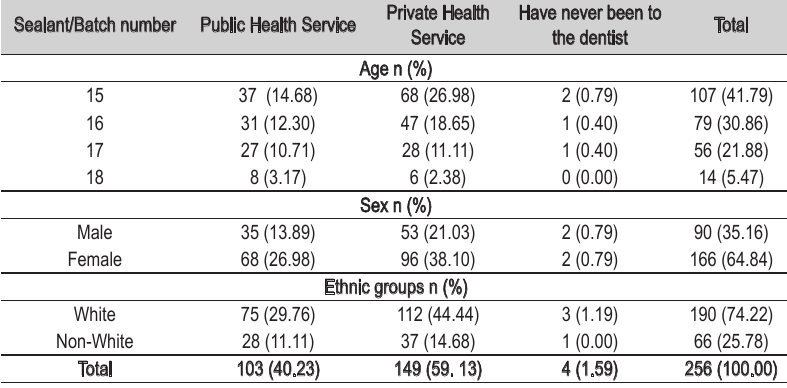
Table 1 - Sample distribution according to the access to oral health services, Agudos, SP, 2012.